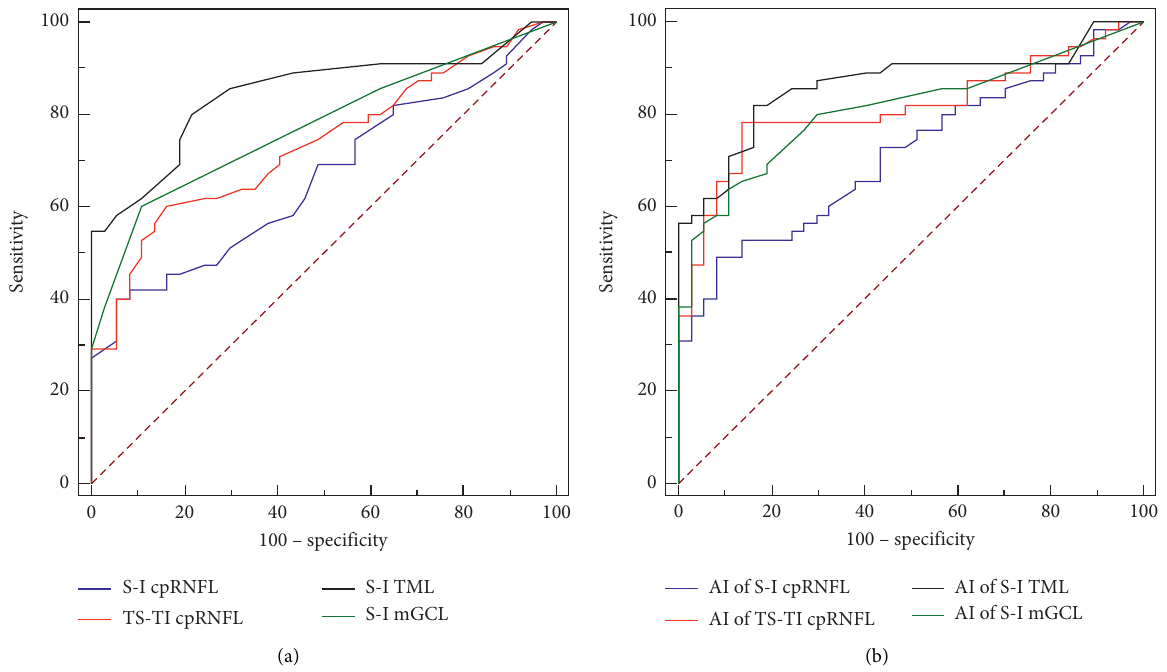
Figure 2: (a) AROC curves for thickness differences of S-I cpRNFL, TS-TI cpRNFL, S-I TML, and S-I mGCL for discriminating highly myopic normal-tension glaucoma from highly myopic control subjects. (b) AROC curves for AI of S-I cpRNFL, TS-TI cpRNFL, S-I TML, and S-I mGCL for discriminating highly myopic normal-tension glaucoma from highly myopic control subjects. AROC: areas under the receiver operating characteristic. AI: asymmetry index. S-I cpRNFL: thickness difference of circumpapillary retinal nerve fiber layer between superior and inferior quadrants. TS-TI cpRNFL: thickness difference of circumpapillary retinal nerve fiber layer between temporal-superior and temporal-inferior sectors. S-I TML: thickness difference of total macular layer between superior and inferior hemispheres. S-I mGCL: thickness difference of macular ganglion cell layer between superior and inferior